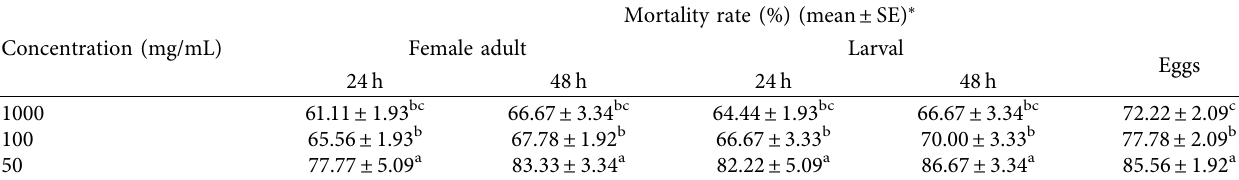
Table 2: The contact effect of Plectranthus tomentosa extract on Tetranychus kanzawai .